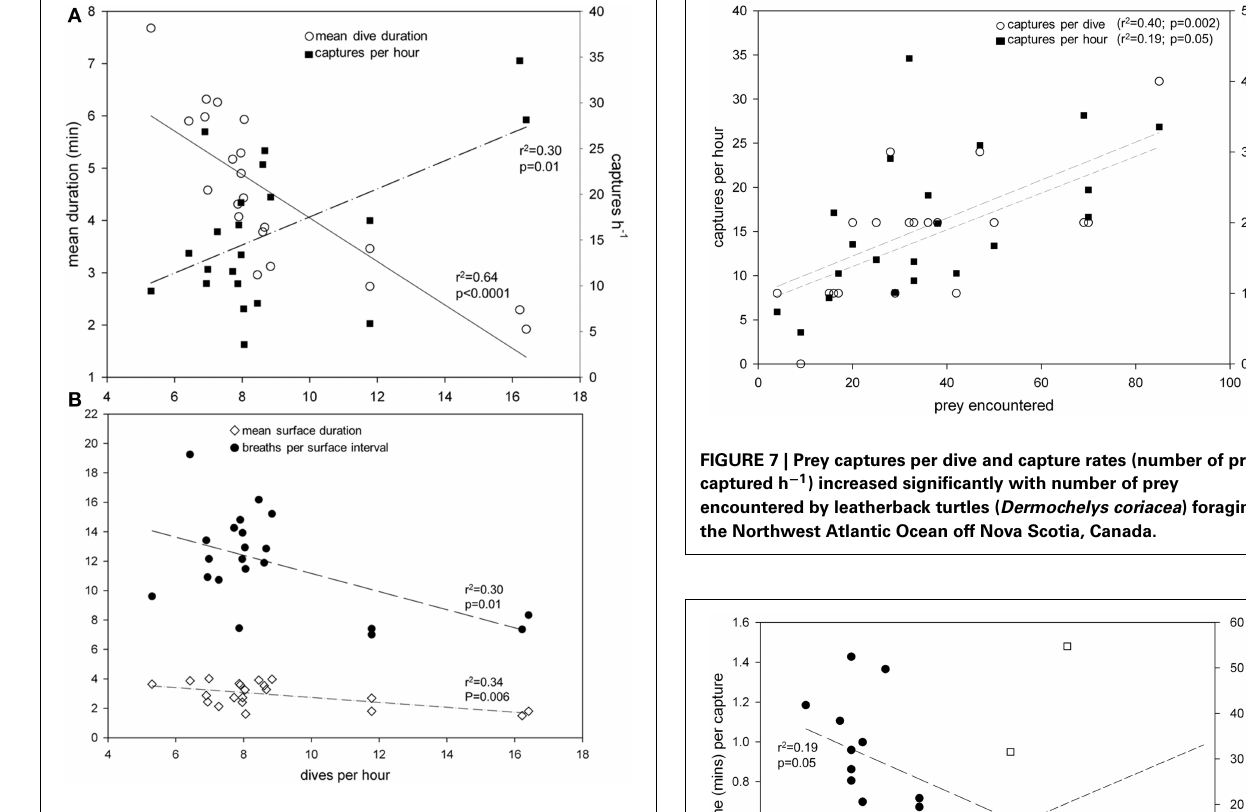
FIGURE 6 | Prey capture rate (number of jellyfish captured h − 1 ) increased and mean dive duration (min) decreased with increased dive rate (dives h − 1 ) (A) of leatherback turtles ( Dermochelys coriacea ) foraging in the Northwest Atlantic Ocean off Nova Scotia, Canada. Dive rate was also inversely related to mean surface duration (min) and breaths per surface interval (B) .